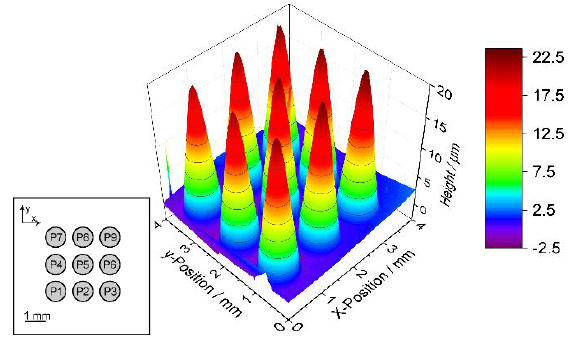
Fig. 2. Measured three-dimensional surface data of a fabricated 174˚ axicon array with indications of the lens positions.